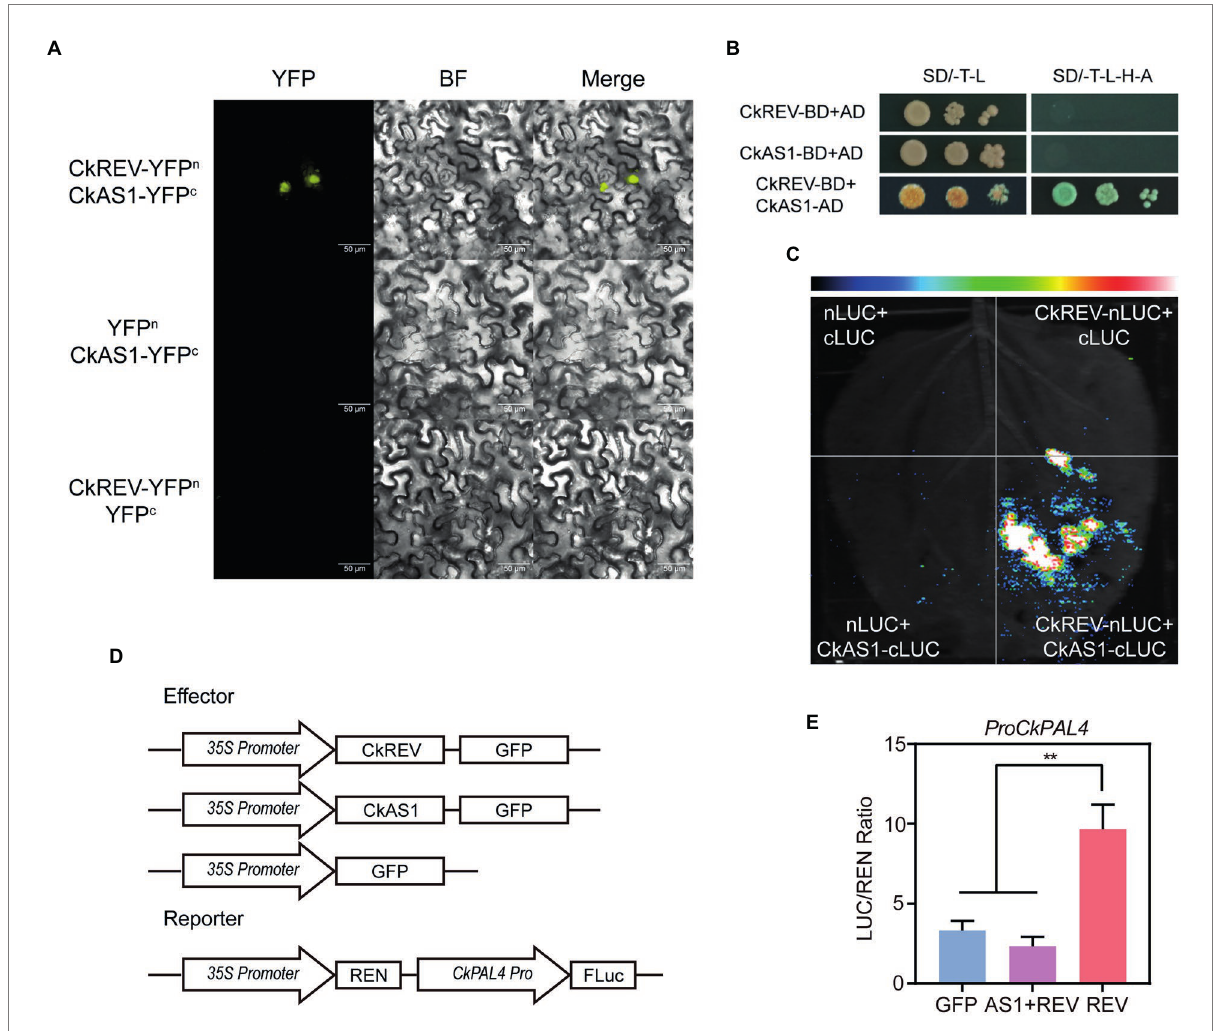
FIGURE 5 CkAS1 is involved in the negative regulation of downstream genes by CkREV. (A) BiFC assay for CkREV and CkAS1 interaction. (B) Y2H assay for CkREV and CkAS1 interaction. (C) LCI assay for CkREV and CkAS1 interaction. (D) Pattern graph of DUAL-LUC assay on the regulation of CkREV and CkAS1 on CkPAL4. (E) The interaction of CkREV with CkAS1 inhibits the induction of downstream genes by CkREV. Error bars indicate SD ( n = 3). (E) Student’s t -test is employed to measure statistical significance between two samples with confidence level at 0.95 (** p <